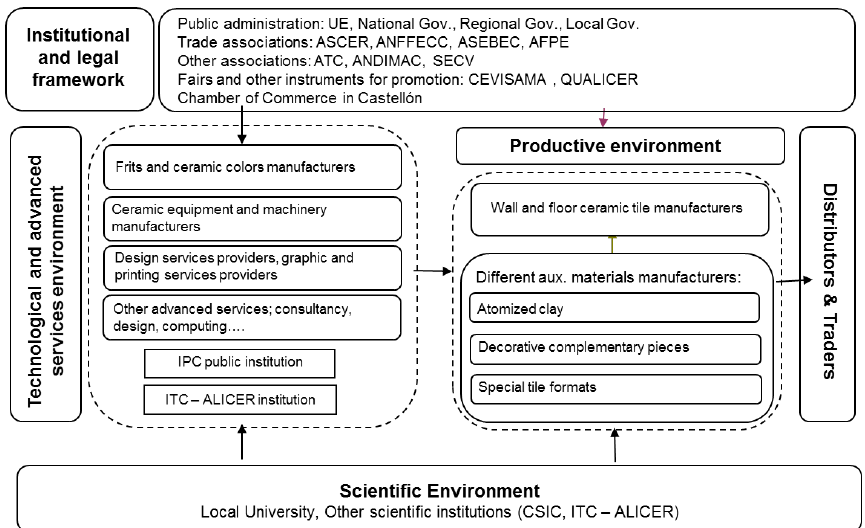
Figure 1. Ecosystem of innovation of the ceramic tile cluster in Castellón. Source: own elaboration based on [74].